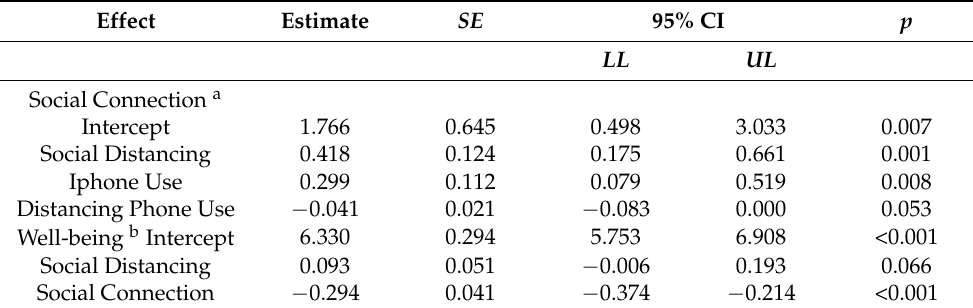
Table 2. Study Results from PROCESS Model 7